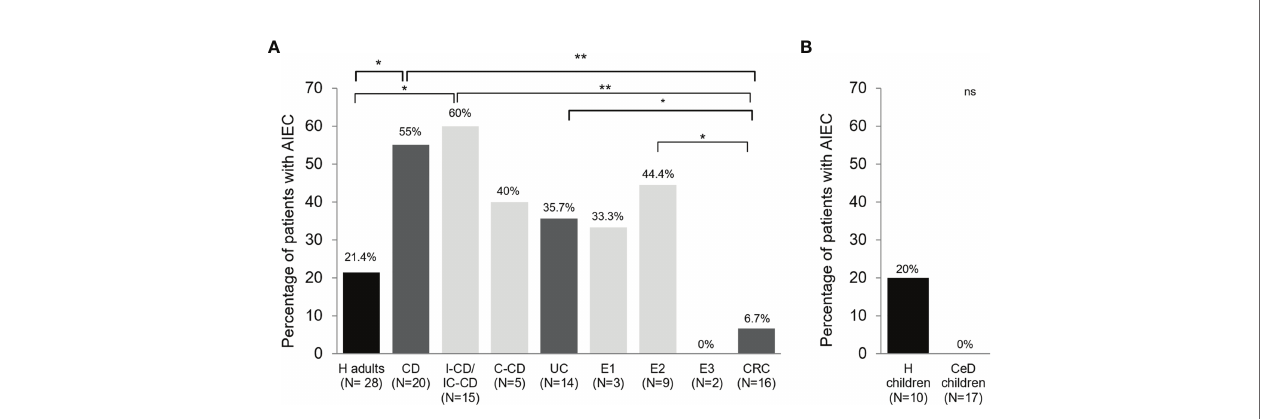
FIGURE 1 | AIEC prevalence in patients with different intestinal diseases and control subjects in biopsy samples (A) and feces (B) . Prevalence has been calculated as the frequency of patients with at least one AIEC or AIEC-like strain recovered from any of the samples analyzed. Data from Crohn ’ s disease (CD) patients and healthy adults controls (H) has been extracted from a previous study (2). Bacteria from pediatric patients were previously isolated from fecal samples (29). IC-CD, ileocolonic Crohn ’ s disease; I-CD, ileal Crohn ’ s disease; C-CD, colonic Crohn ’ s disease; UC, ulcerative colitis; E1, proctitis; E2, left-sided colitis; E3, pancolitis; CRC, colorectal cancer; CeD, coeliac disease. ns, not signi fi cant; *p ≤ 0.05; **p ≤